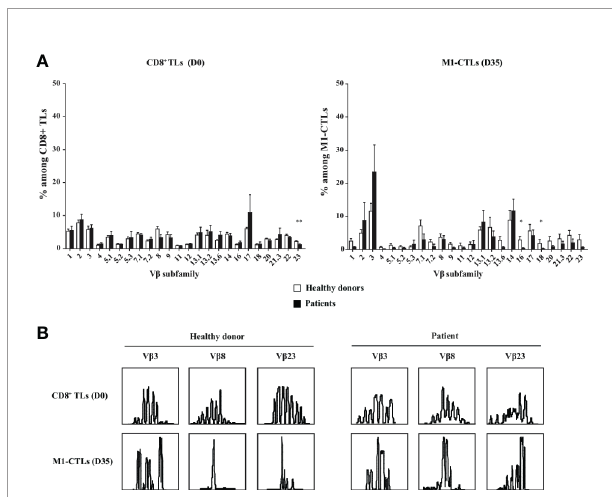
FIGURE 2 | M1-CTL repertoire displays an oligoclonal response and an expansion restricted to some V b subfamilies. (A) Histograms of the V b subfamily relative percentages on puri fi ed CD8 + TLs at D0 and on M1-CTLs at D35, using FITC-, PE- or FITC-PE-labeled antibodies are displayed. Histograms were obtained from ten healthy donors (white bars) and six patients (black bars) and shown with standard errors of means. Statistical tests ( t test) were performed to compare both groups. * p < 0.05, ** p < 0.01. (B) Two representative examples of immunoscopes obtained with puri fi ed CD8 + TLs at D0 (upper panels) and with M1-CTLs at D35 (lower panels) for a healthy donor (left panels) and a patient (right panels) are represented. For both groups, representative examples of expanded (V b 3), stable (V b 8) and decreased (V b 23) populations respectively are